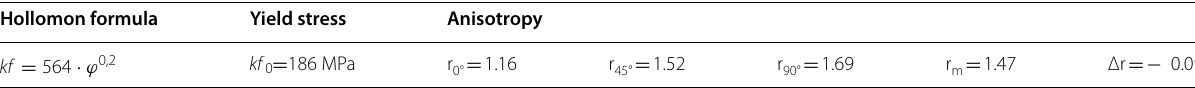
Table 1 DC04 material